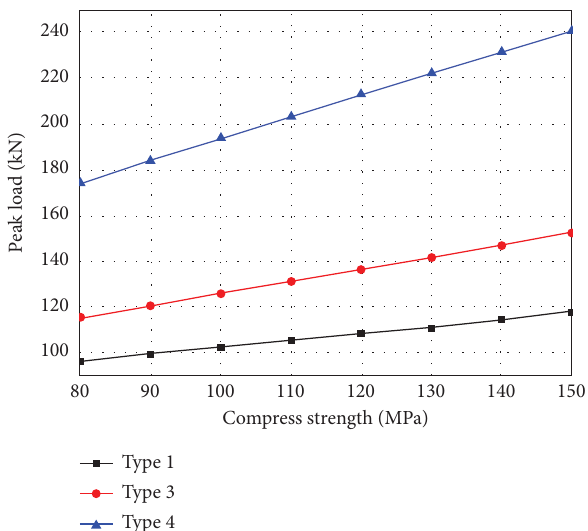
Figure 14: Te peak load change with the compressive strength of UHPC.